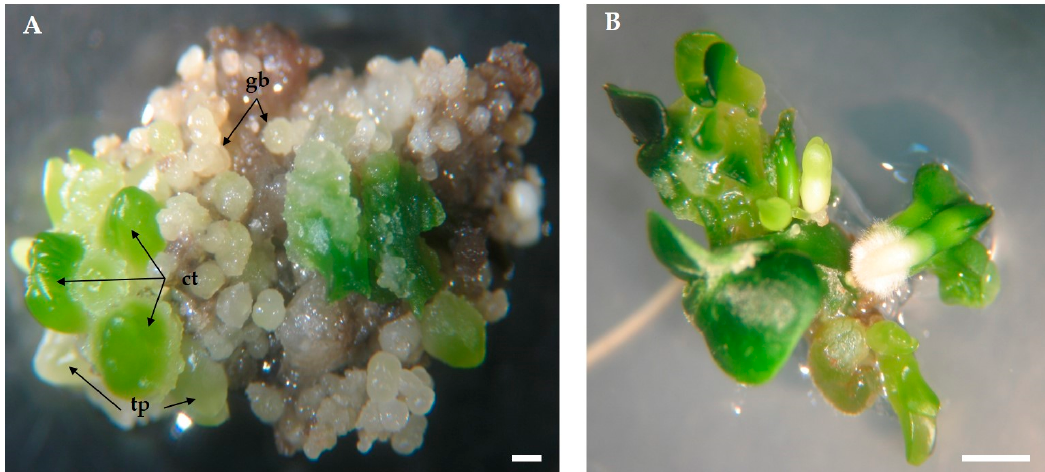
Figure 5. Embryogenic calli from radicle in ECO medium under 16 h photoperiod. ( A ) After first sub-culture with the identification of somatic embryos at different developmental stages (gb: globular, tp: torpedo, ct: cotyledonary), ( B ) After the 3rd sub-culture with secondary embryogenesis visible. Bars: 10 mm.